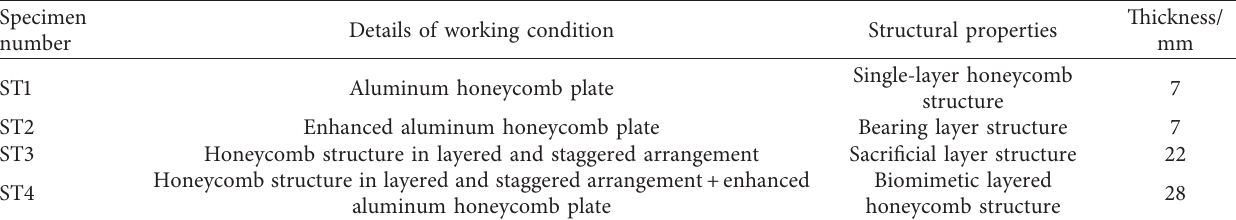
Figure 9: Schematic diagram of different specimens. (a) Biomimetic layered honeycomb structure. (b) Single-layer honeycomb structure. (c) Sacrificial layer structure. (d) Bearing layer structure. Table 1: Groups of simulated explosion test on shock tube.